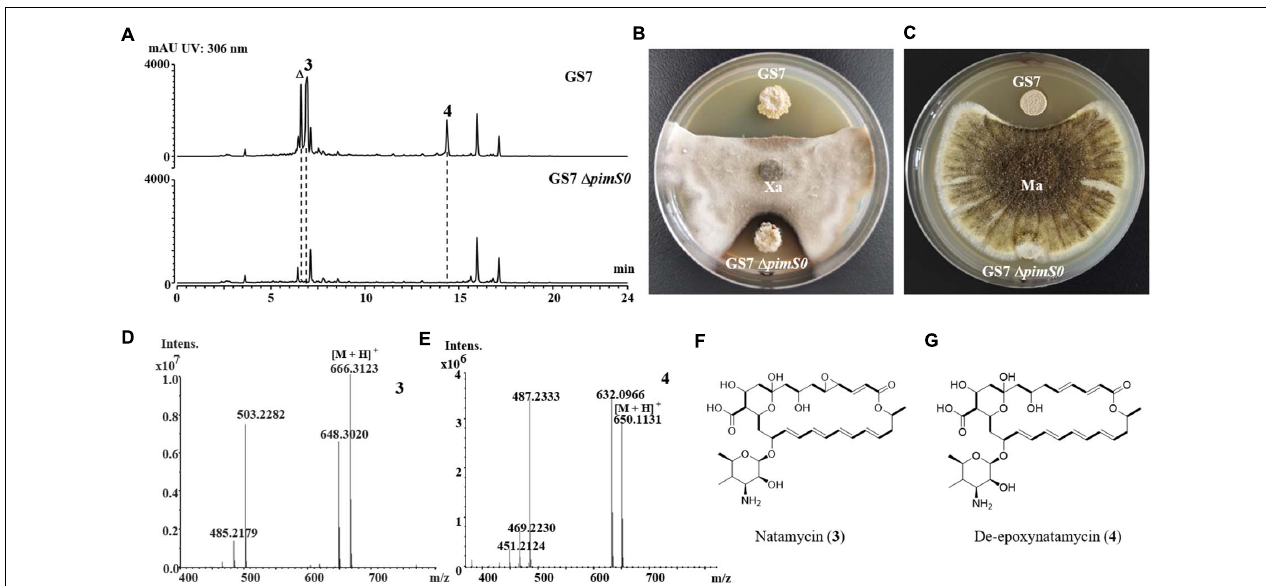
FIGURE 6 | The deletion mutant of natamycins in Streptomyces sp. GS7 had weaker antifungal activities against Xylaria sp. and Metarhizium anisopliae . (A) HPLC profiles of the metabolites of Streptomyces sp. GS7 wild type and the GS7 (cid:49) pimS0 mutant. The triangle symbol ( (cid:49) ) denotes a homolog of natamycin. (B,C) Paired challenge assays of GS7 and the deletion mutant (GS7 (cid:49) pimS0 ) against Xylaria sp. (Xa, B ) and M. anisopliae (Ma, C ). (D,E) HRMS spectra of compounds 3 and 4 from GS7. (F,G) The predicted chemical structures of natamycin/pimaricin (3) and de-epoxynatamycin/de-epoxypimaricin (4).